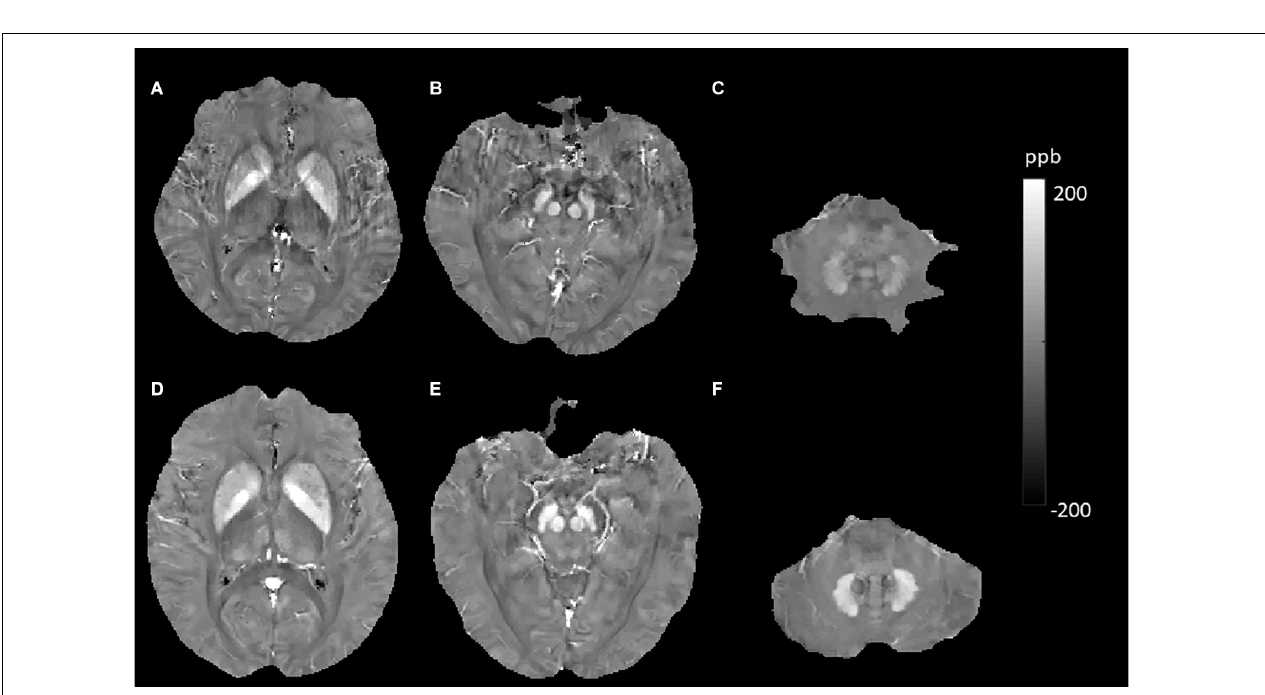
FIGURE 6 | Evolution of susceptibility values with type 2 diabetes mellitus (T2DM) effect in the putamen, caudate nucleus, red nucleus, and dentate nucleus. The upper row (A–C) shows susceptibility images of a 55-year-old male non-smoker without hypertension and T2DM (first). The bottom row (D–F) shows quantitative susceptibility mapping (QSM) images of a 52-year-old male non-smoker with T2DM but without hypertension (second). Susceptibility values of the putamen, caudate nucleus, red nucleus, and dentate nucleus were higher in the second participant than in the first participant.